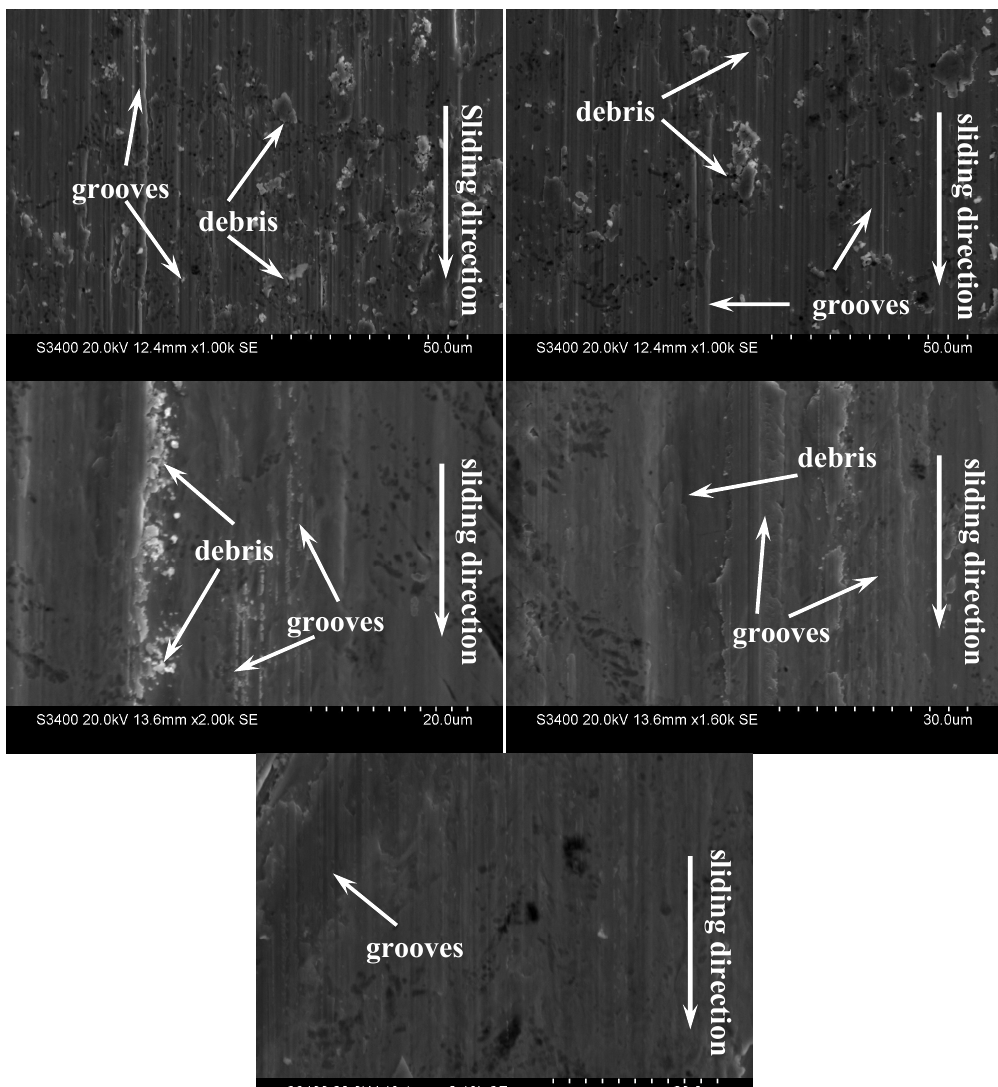
Figure 4. The morphology of FeCoCrNiAlTi x HEA coatings after wear.